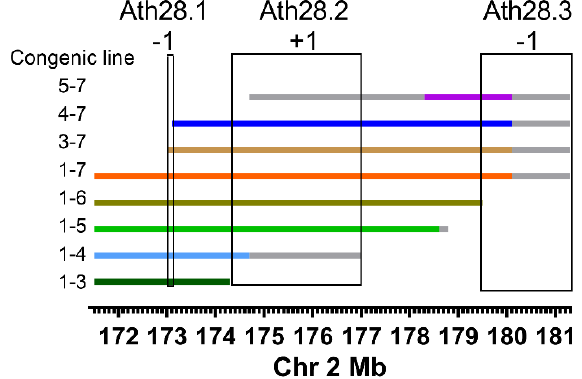
Figure 1. Ath28 subcongenic strains and aortic root lesions. The map positions of the eight strains that cover this region, areas between mapped markers are shown in gray. The boxed regions show the position of three putative atherosclerosis QTLs with the − 1 and +1 scores where the AKR alleles are associated with smaller and larger lesions, respectively.